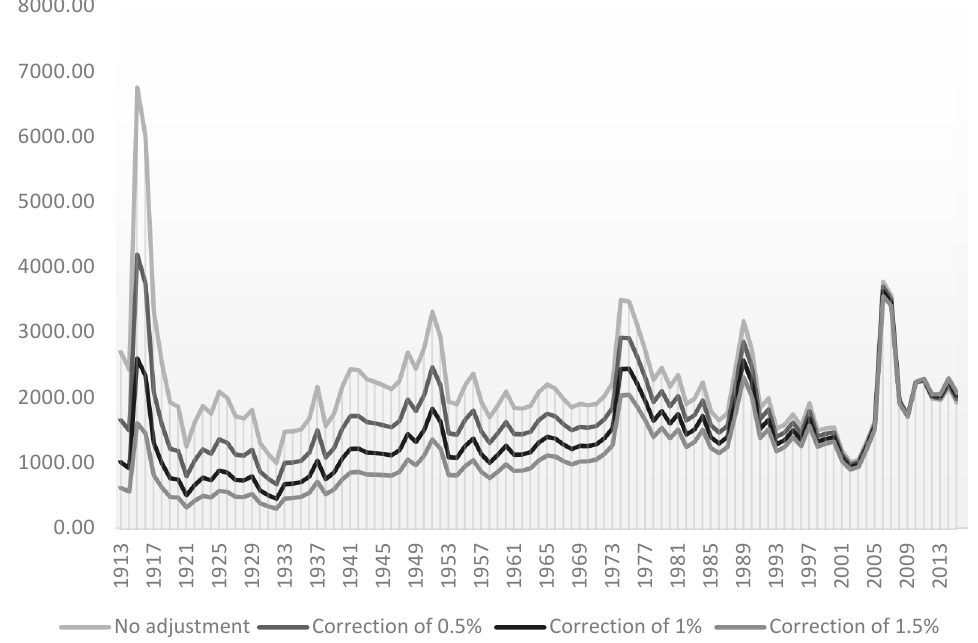
Figure 3. Annual zinc real prices in dollars per metric ton ($/ton) from 1913 to 2015 (2010 = 100%).